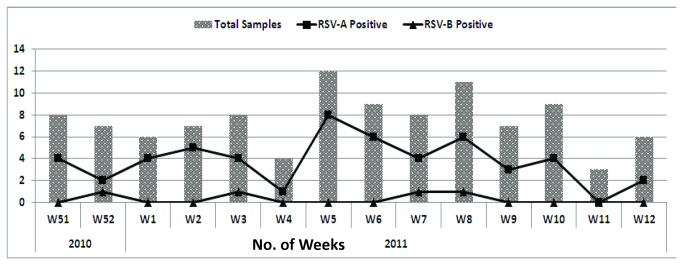
Weekly and Monthly Distribution of RSV-positive cases from Dec 2011-March 2012.